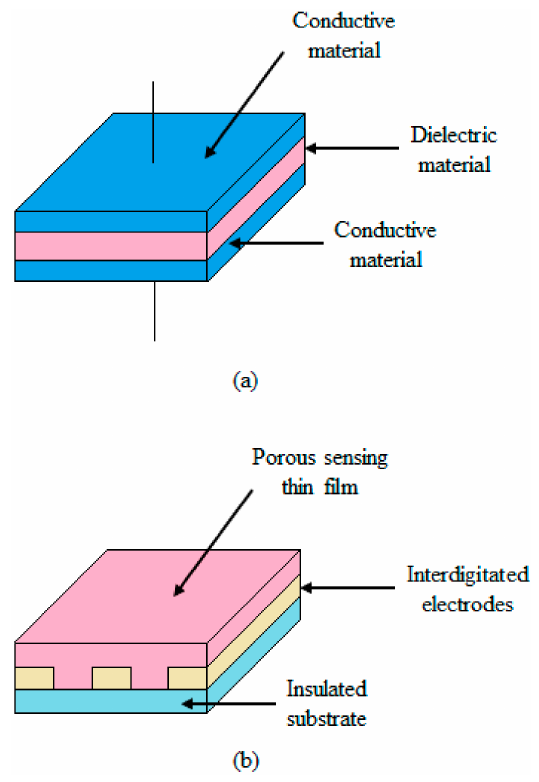
Figure 1. ( a ) Schematic diagram of IDE based capacitive-type thin film humidity sensor; ( b ) schematic diagram of IDE based resistive-type thin film humidity